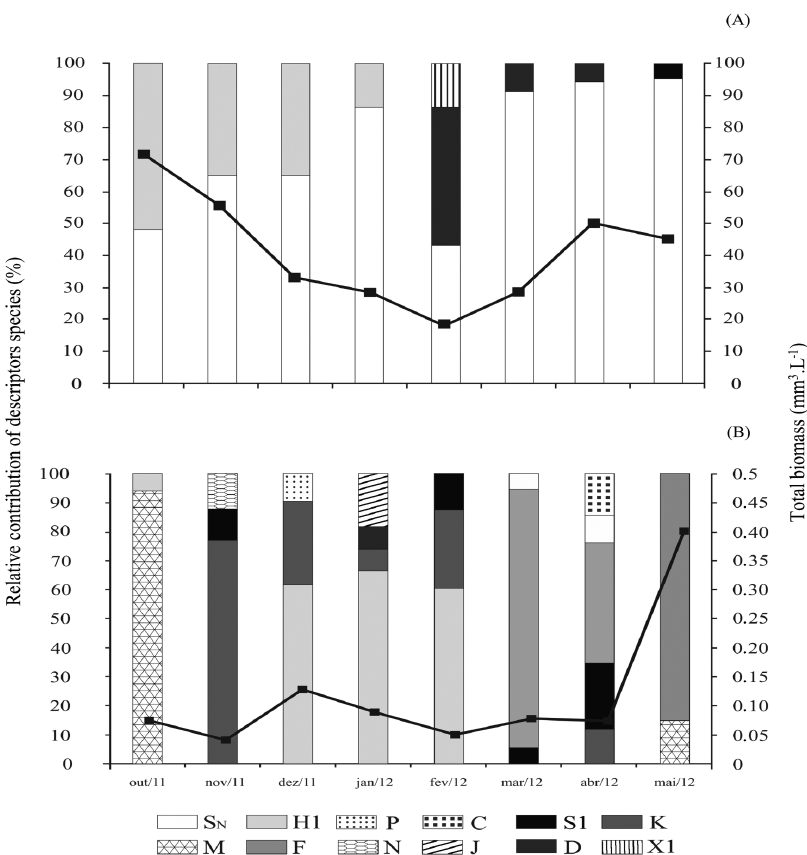
Figure 5. Relative contribution of phytoplankton functional groups (Reynolds et al., 2002) and total biomass (mm 3 .L –1 ) from October 2011 to May 2012 in the Pau dos Ferros (A) and Santa Cruz do Apodi (B) reservoirs.